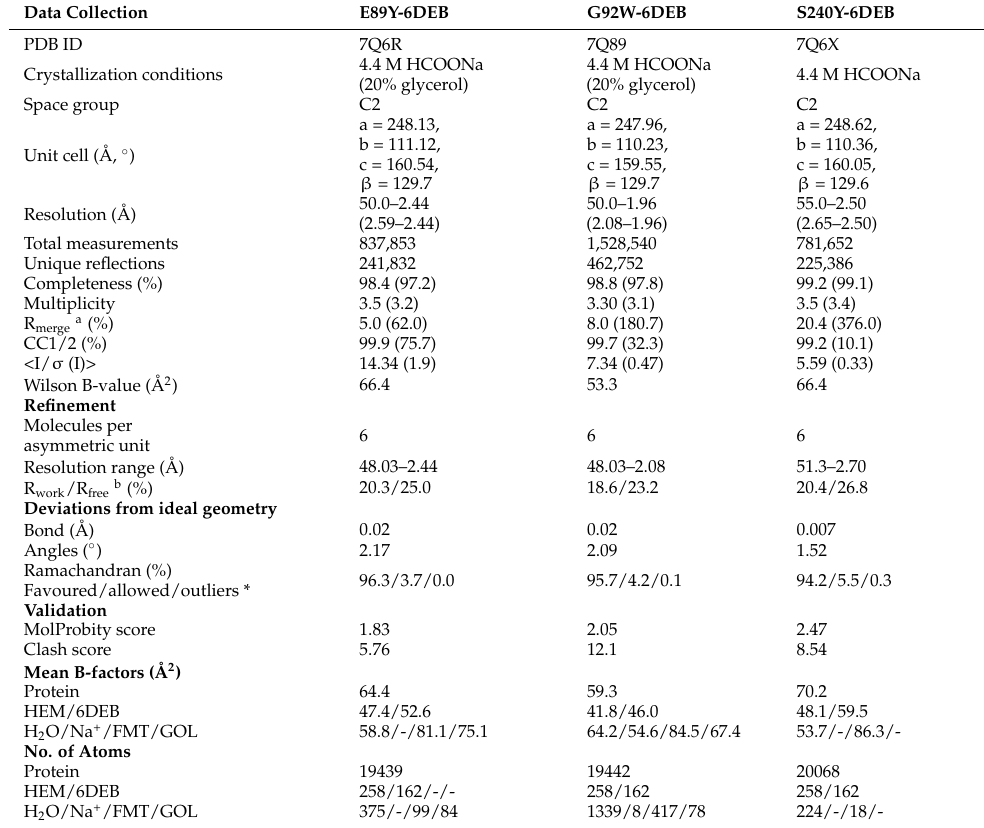
Table 1. Data collection, refinement, statistics, and validation. The highest-resolution shell is shown in